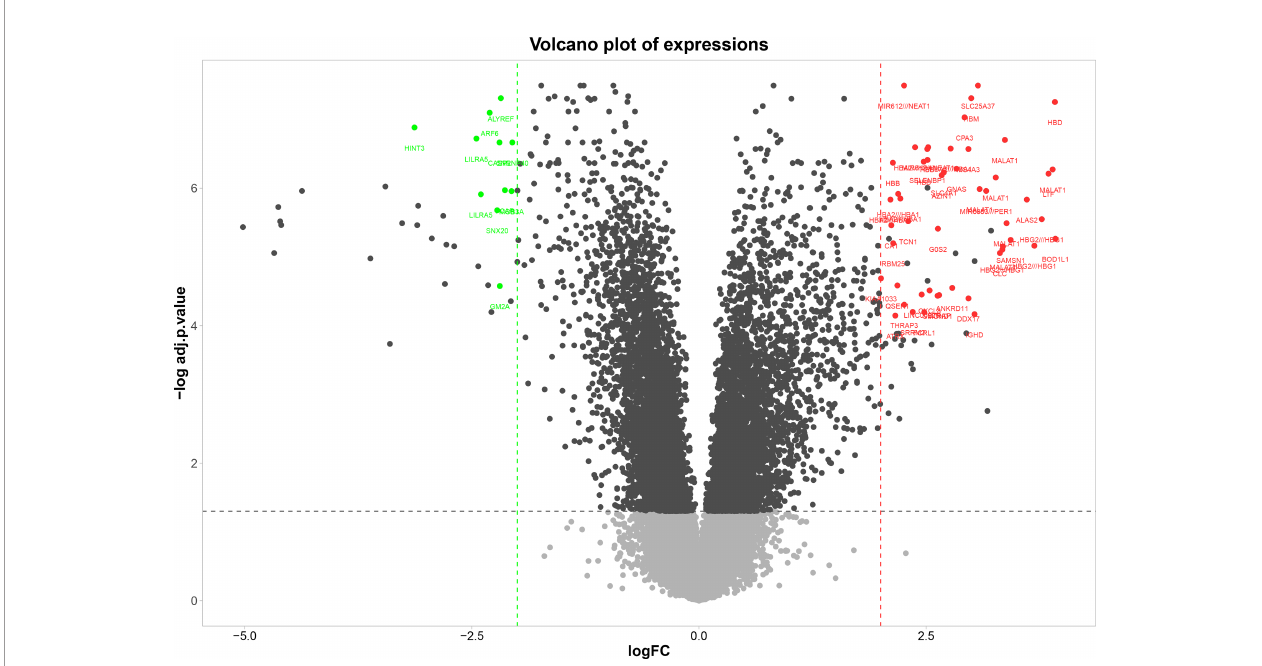
FIGURE 1 | Volcano plot of DEGs between MS and healthy samples. Volcano plot, the vertical axis (y-axis) is the mean value of- log 10 (adj P-value), and the horizontal axis (x-axis) is the value of logFC. Red dots denote the up-regulated genes; green dots represent the down-regulated